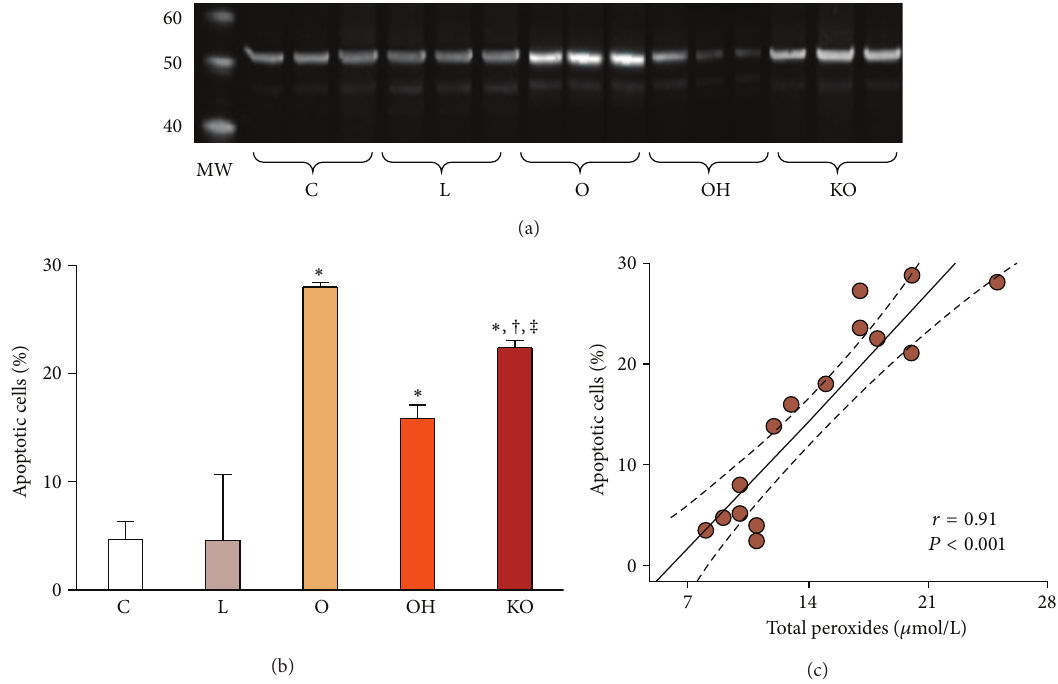
Figure 5: (a) Western blot analyses for caspase 9; (b) percentage of apoptotic cells; (c) relationship between total peroxide concentrations and the percentage of apoptotic cells in HUVEC cell homogenates ( 𝑛 = 3 , for each experiment). Endothelial cells were incubated over 24 h with 50 mg/L isolated human LDL (L); 50mg/L oxidized LDL (O); 50mg/L oxidized LDL + 40 mg/L HDL from wild type mice (OH); 50mg/L oxidizedLDL+40 mg/LHDLfromPON1 (−/−) mice(KO);orwithserum-freemediaascontrols(C).MW:molecularweightmarker. ∗ 𝑃 < 0.01 with respect to C; † 𝑃 < 0.05 with respect to OH; ‡ 𝑃 < 0.01 with respect to